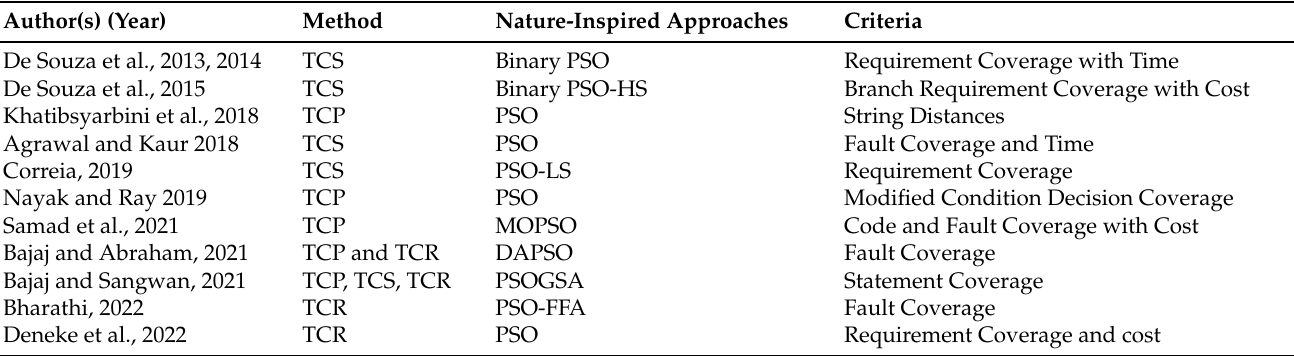
Table 1. Summary of PSO Algorithms used in Regression